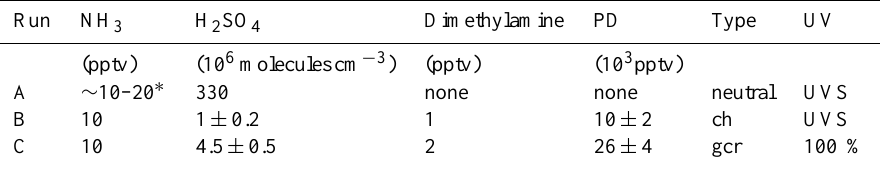
Table 1. Summary of the experiments analysed in this study. The experiments were performed in the presence of sulphuric acid (H 2 SO 4 ) and ammonia (NH 3 ) (Exp. A), and pinanediol (PD) (Exp. B–C). NH 3 , H 2 SO 4 , DMA and PD refer to gas-phase concentrations of ammonia, sulphuric acid, dimethylamine and pinanediol, respectively; “type” indicates run conditions (ch: pion beam in use, gcr: natural galactic cosmic rays only); “UV” indicates UV-lamp aperture opening in % or UVS; d dry is TDMA dry particle diameter; d ccn is CCNC selected dry particle diameter. The ozone (O 3 ) concentration was ∼ 500 ppb for Exp. A and below 100ppb for Runs B–C. Run NH 3 H 2 SO 4 Dimethylamine PD Type UV (pptv) (10 6 moleculescm − 3 ) (pptv) (10 3 pptv) A ∼ 10–20 ∗ 330 none none neutral UVS B 10 1 ± 0.2 1 10 ± 2 ch UVS C 10 4.5 ± 0.5 2 26 ± 4 gcr 100